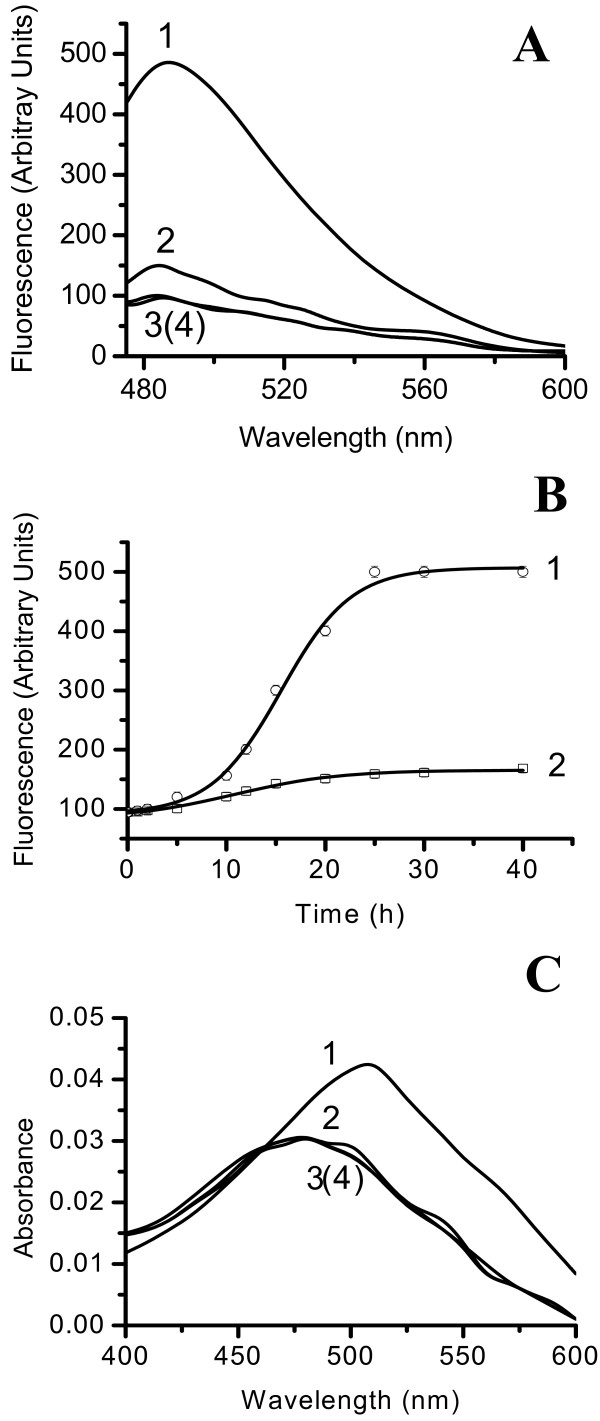
Changes in fluorescence spectra of thioflavin T and absorption spectra of Congo Red in the presence of tau deposits. (A) Thioflavin T (10 μM final concentration) was incubated with 0.1% aldehyde-treated tau (2 μM) in 100 mM potassium phosphate buffer pH 7.2 for 15 min before measurement. Emission spectra of ThT were recorded (excitation at 450 nm) in the presence of formaldehyde-treated tau (curve 1), self-aggregated tau (curve 2), acetaldehyde-treated tau (curve 3) and in the absence of protein (curve 4). (B) Kinetics of the increase in the fluorescence emission of ThT incubated with formaldehyde-treated tau (curve 1) or self-aggregated tau (curve 2). (C) Under the same conditions, Congo Red (5 μM final concentration) was incubated with formaldehyde-treated tau (curve 1), acetaldehyde-treated tau (curve 2) or native tau (curve 3) for 15 min before measurement. Congo Red alone is shown as a control (curve 4).